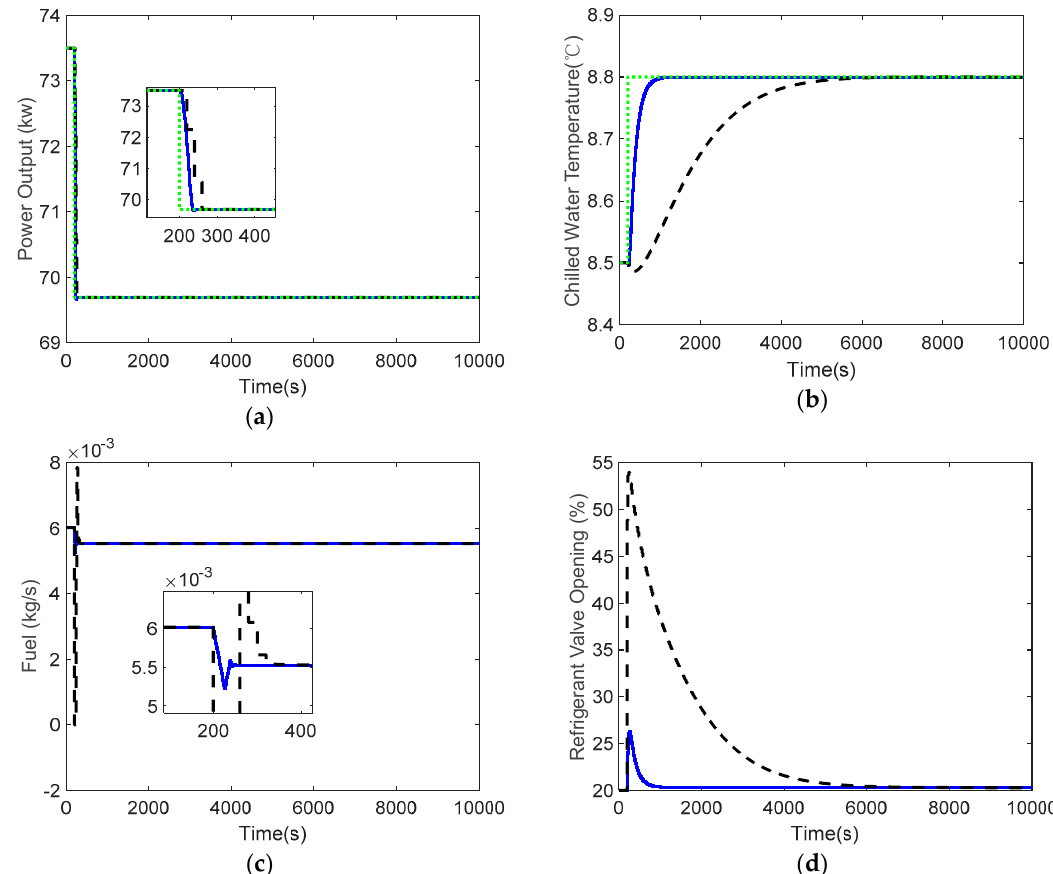
Figure 11. Case 1: Load tracking performance of the MGT-CCP system (Solid in blue: proposed